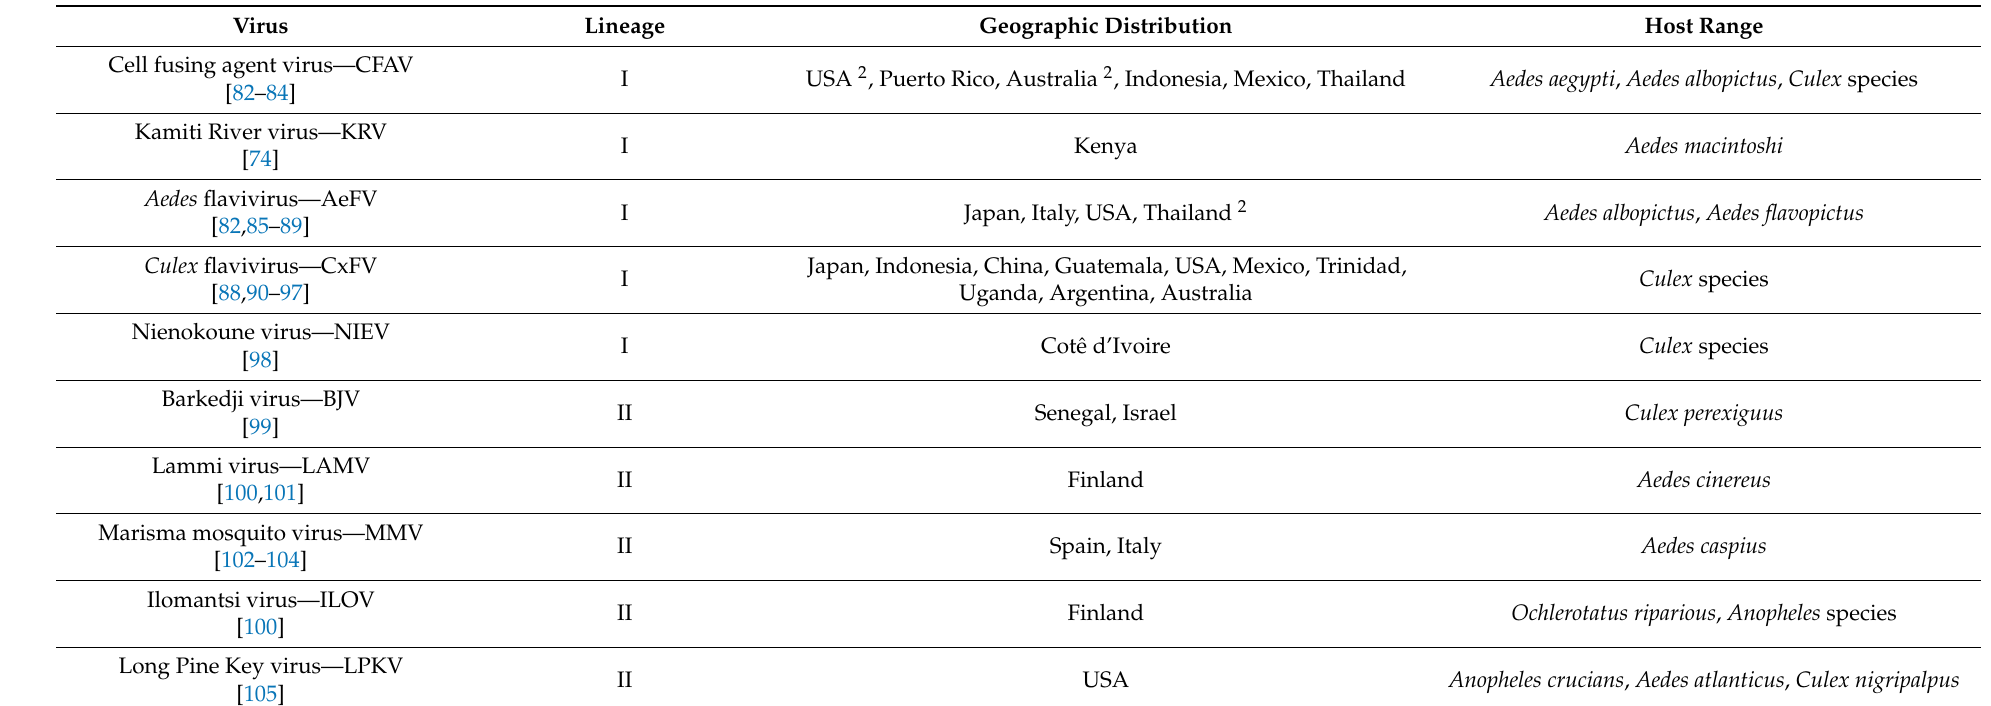
Table 3. Geographic distribution and host range of insect-specific flaviviruses 1